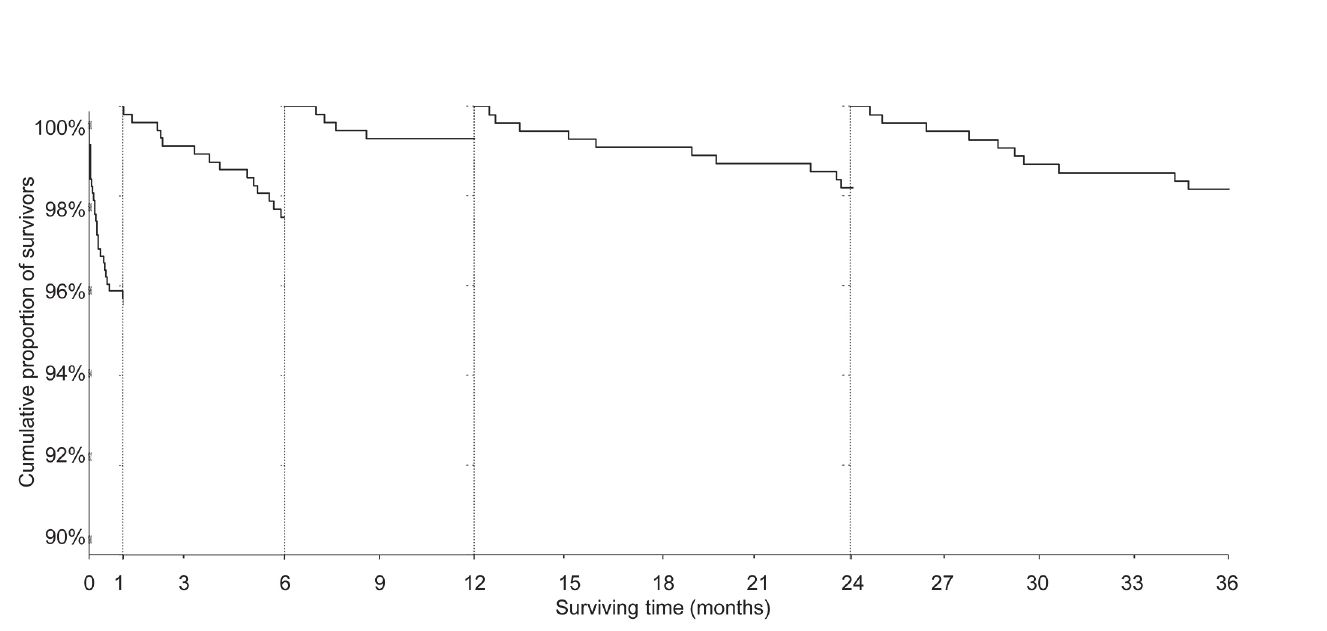
Fig 4. Landmark analyses of mortality after